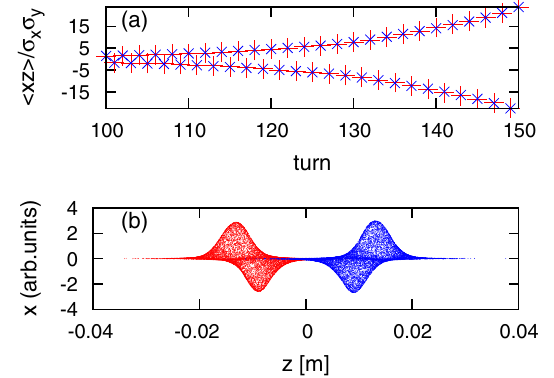
FIG. 6. Particle-tracking simulation of the two beams correlated by the cross-wake force in SuperKEKB with a detuned beta, ξ ¼ 0 . 0054 , θ ¼ 8 . 0 (transparent). (a) Evolution of h xz i , and x P (b) beam distribution of the x − z plane at the collision. The red and blue points represent the e þ and e − beams, respectively. ¼ 0 . 0054 and θ ¼ 8 . 0 . Plot (a) shows the evolution that ξ x P